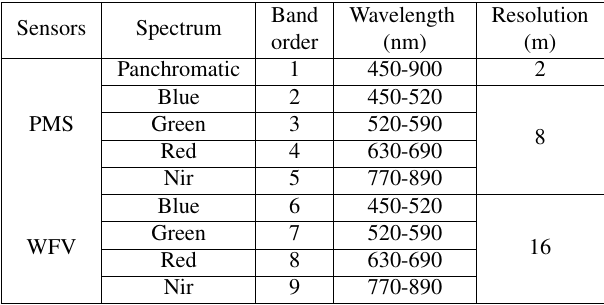
Table 1. Characteristics of GF-1 PMS Satellite Image (data from http://www.cresda.com)